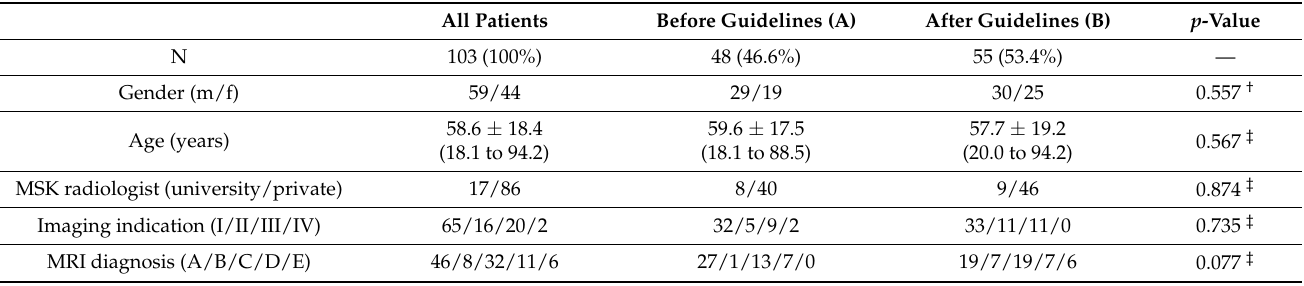
Table 2. Demographics of the